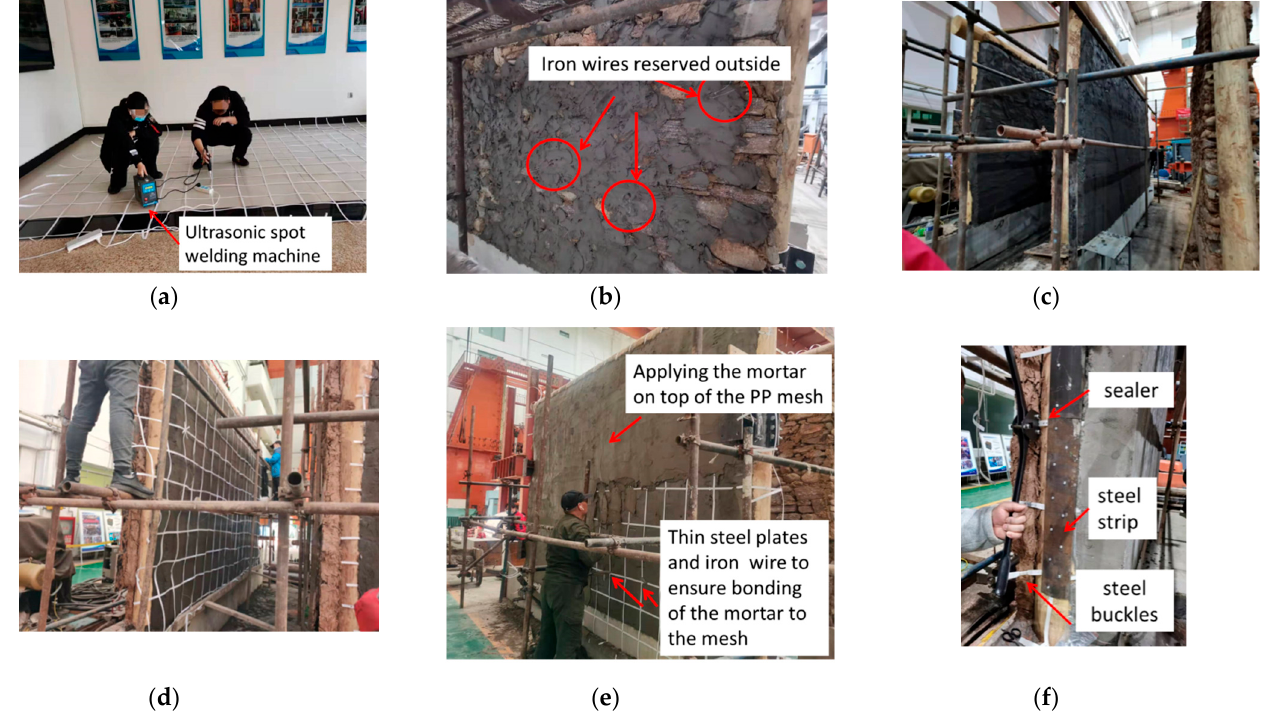
Figure 6. PP band retrofitting procedure for timber frame with mud and stone infill: ( a ) welding of the PP band mesh; ( b ) filling the gap using cement mortar; ( c ) applying the cement mortar at the bottom surface; ( d ) installing the PP band mesh; ( e ) applying the cement mortar at the top surface; and ( f ) anchoring the PP band connection between the timber frame and the infill.